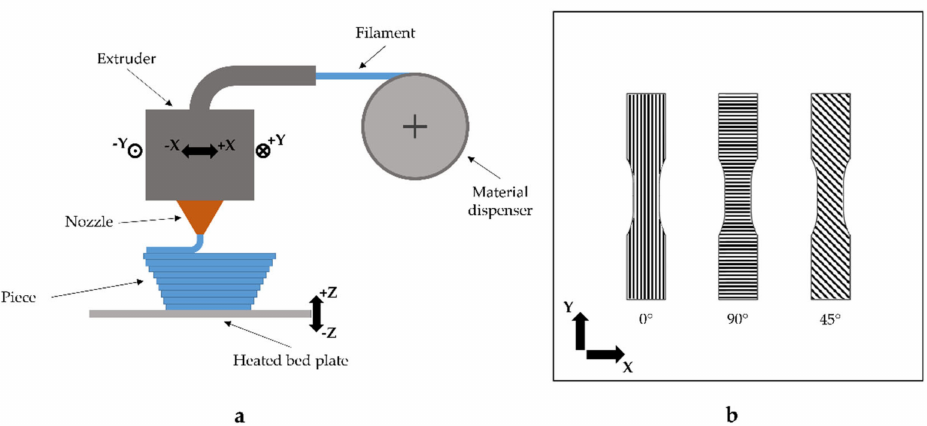
Figure 1. Schematic representation of the Fused Filament Fabrication (FFF) process ( a ) and build orientation ( b